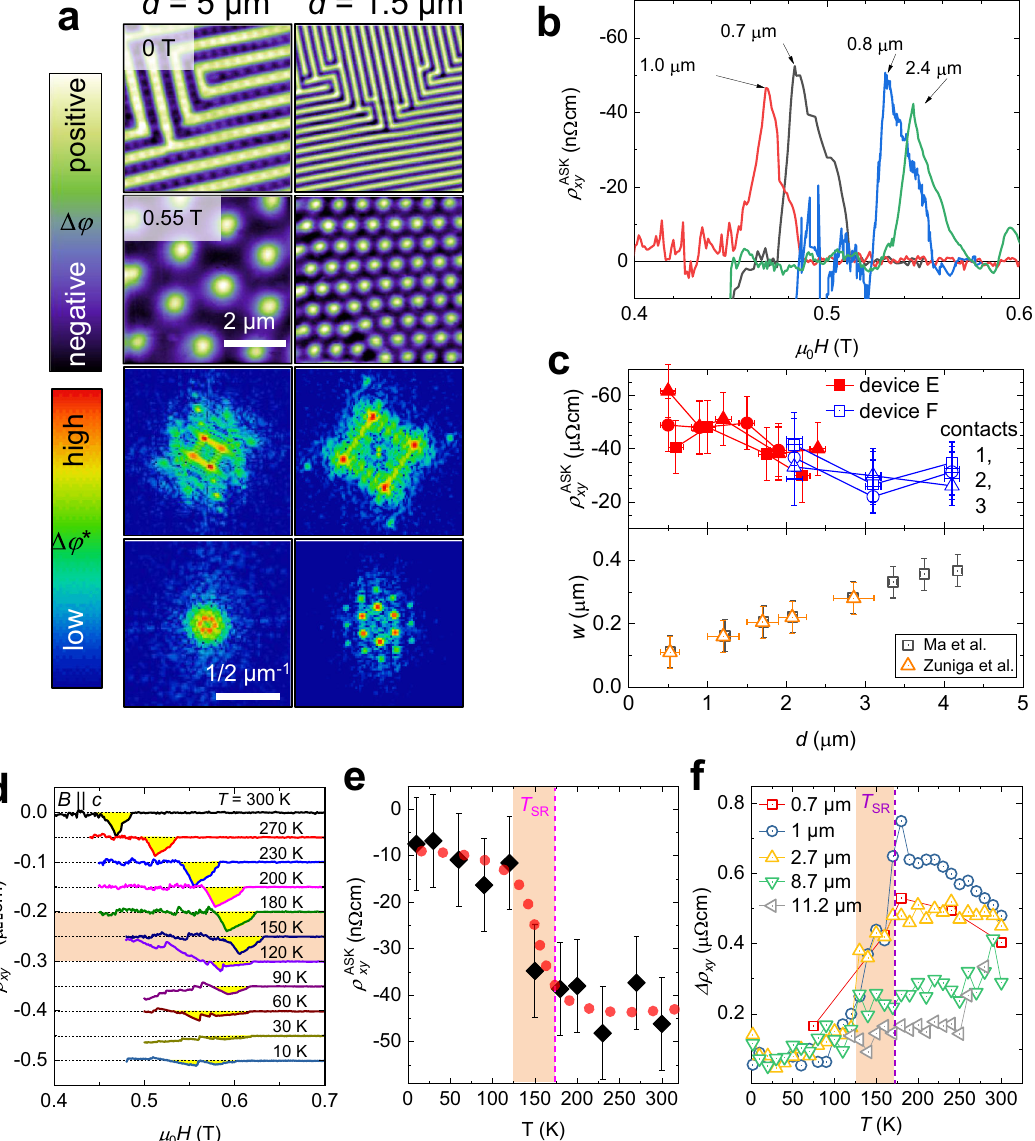
Fig. 3 Thickness and temperature dependence of the magnetic textures and Hall component associated with ASKs. a MFM images (local magnetic z component represented by Δ ϕ showing chiral domains and an ASK lattice for two samples prepared by FIB patterning with thicknesses of 5 and 1.5 μ m. The data were recorded at room temperature in zero fi eld and at 550 mT applied parallel to the c axis, i.e., parallel to the line of sight. The lower panels show the respective FFTs (in arb. unit with logarithmic color scale). b ASK Hall component, ρ ASK xy , plotted against magnetic fi eld for devices B, C, E, and G with thicknesses of 1, 2.4, 0.7, and 0.8 μ m, respectively. c Thickness dependence of ρ ASK xy compared to the domain periodicity, w , determined by recent MFM measurements 22,27 . The error bars represent the standard deviation of the values for variations in the details of the background subtraction. d ρ ASK xy for temperatures between 10 and 300 K for device B with d = 1 μ m. e Maximum amplitude of ρ ASK xy in device B ( d = 1 μ m) plotted against temperature. Red dots are a guide to the eye. The error bars are de fi ned as in c . f Temperature dependence of the maximum difference in the Hall-resistivity loop, Δ ρ xy between up and down sweeps for devices A, B, and